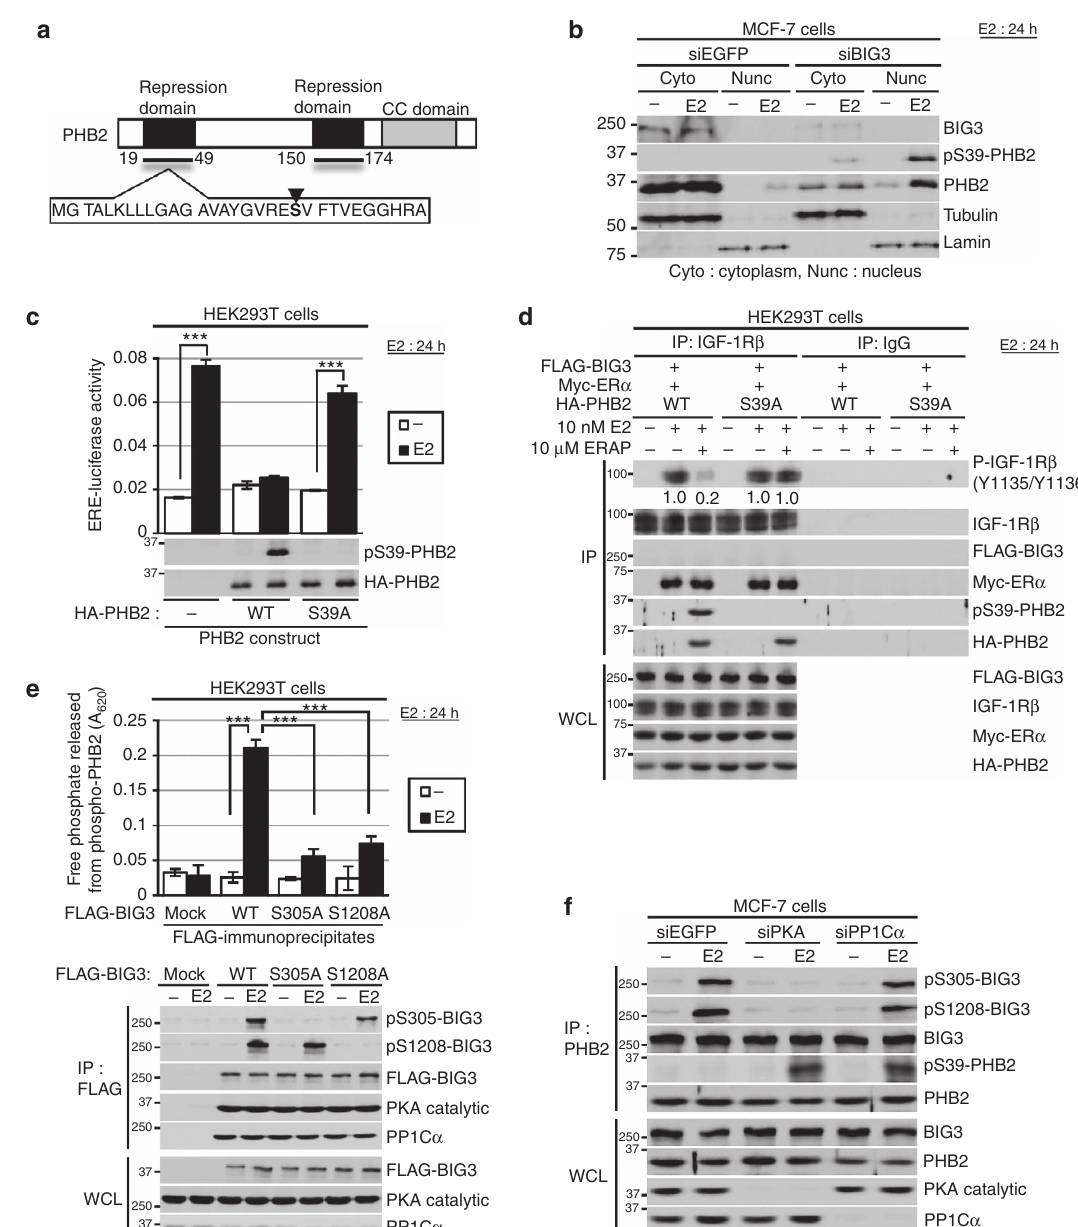
Figure 2 | BIG3-PKA-PP1C a regulates the suppressive ability of PHB2. ( a ) The schematic representation of human PHB2. The black inverted triangle indicates S39 of PHB2. ( b ) The subcellular localization of phospho-PHB2 S39 after siBIG3 treatment in the presence of E2. a / b -Tubulin (tublin) and laminin B (lamin) were used as loading controls for the cytoplasmic and nuclear fractions, respectively. ( c ) Upper, Luciferase assays showing the inhibitory activity of phospho-PHB2 S39. The indicated PHB2 (WT, S39A), ER a , ERE-luciferase, and pRL-TK construct-transfected HEK293Tcells were exposed to E2 for 24h and analysed for luciferase and Renilla -luciferase activities. Data are normalized to Renilla -luciferase and represent the means ± s.e.m. of three independent experiments. Lower, PHB2 S39-phosphorylation. HA-PHB2 and FLAG-ER a -transfected HEK293T cells were stimulated by E2 for 24h. ( d ) The inhibitory effects of PHB2-S39 on IGF-1R b phosphorylation. The indicated PHB2 (WT, S39A) or ER a -transfected HEK293Tcells were exposed to E2 for 24h, followed by immunoprecipitation with IGF-1R b antibody. ( e ) Phosphatase activities of BIG3 against phospho-PHB2-peptide. The indicated FLAG-BIG3 (WT, S305A and S1208A) and HA-ER a -transfected HEK293T cells were treated with E2 for 24h, followed by immunoprecipitation using an anti-FLAG antibody. Phosphatase activity of the immunoprecipitates was measured as described in Methods section. These data represent the means ± s.e.m. of three independent experiments. ( f ) The effects of siPKA and siPP1C a on BIG3 S305 and S1208 phosphorylation, and PHB2 S39-phosphorylation in MCF-7 cells after E2 stimulation for 24h. *** P o 0.001 (two-sided Student’s t